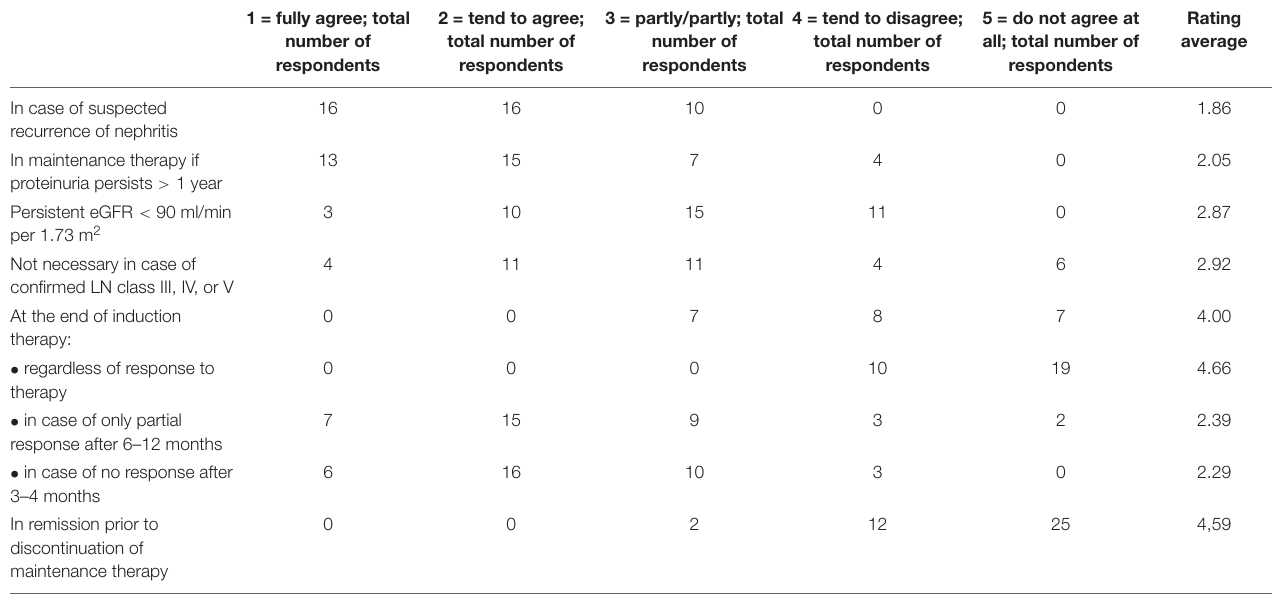
TABLE 6 | Indications for repeat kidney biopsy during follow-up of lupus nephritis (answers by Likert scale: 1 = fully agree, 2 = tend to agree, 3 = partly/partly, 4 = tend to disagree, 5 = do not agree; with rating average of